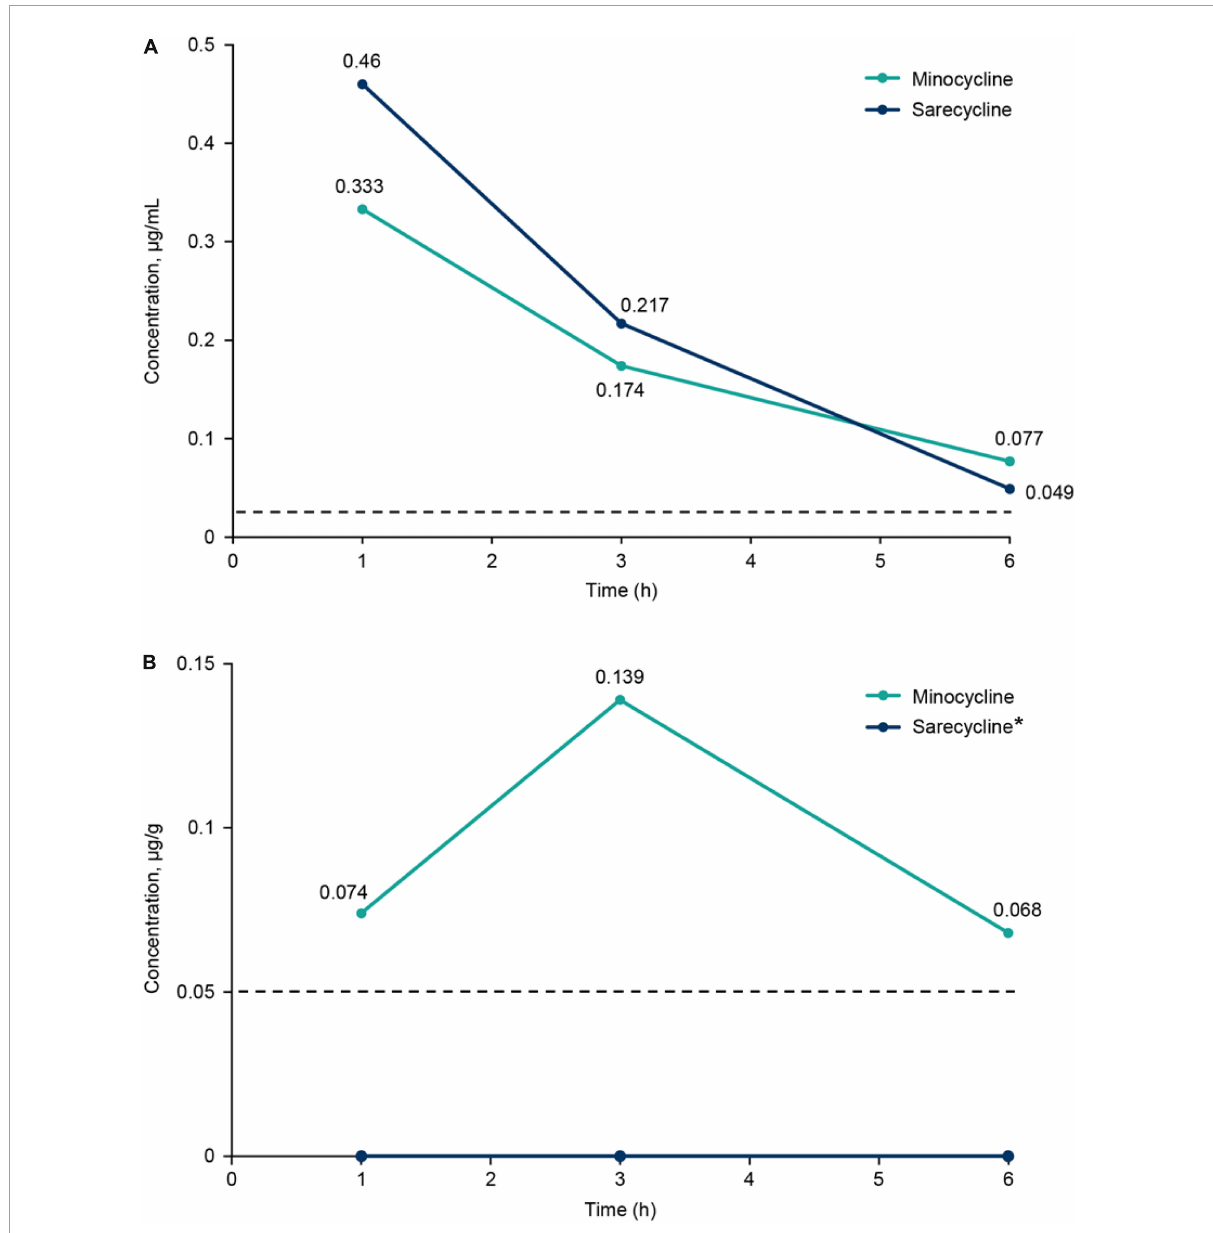
FIGURE2 (A) Plasma concentrations of sarecycline and minocycline following intravenous administration in rats. (B) Brain concentrations of sarecycline and minocycline following intravenous administration in rats. Dashed line indicates limit of quantitation for plasma (0.025 µ g/ml) and brain (0.05 µ g/g). *Concentration of sarecycline in the brain was below the limit of quantitation at all time